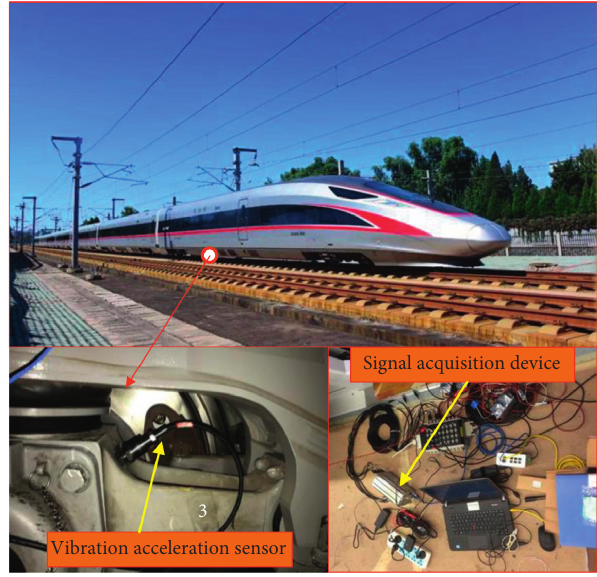
Figure 3: Installation of acceleration sensor at the test site.